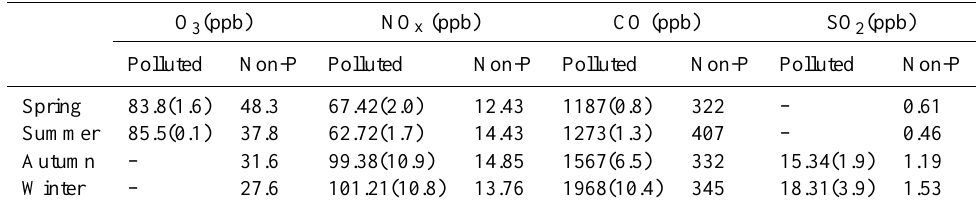
Table 1. Hourly average mixing ratios of the trace gases under polluted conditions (defined in this paper) and non-polluted conditions. The exceedance frequency (%) based on hourly averages is given in the brackets. O 3 (ppb) NO x